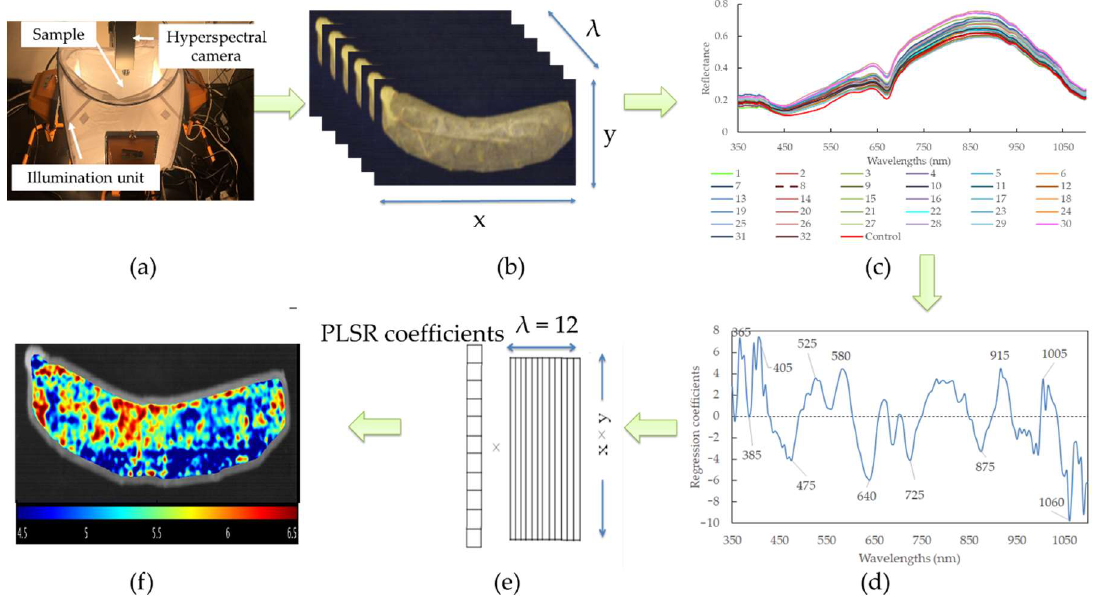
Figure 1. Flowchart of the main steps to design a hyperspectral imaging system for real-time moni- toring of pH in sausages with different modified casings. ( a ) Imaging acquisition; ( b ) hyperspectral image segmentation; ( c ) spectral extraction; ( d ) feature wavelengths selection; ( e ) unfolded image to 2D and multiply the regression coefficients of PLSR model using feature wavelengths; ( f ) prediction map establishment.